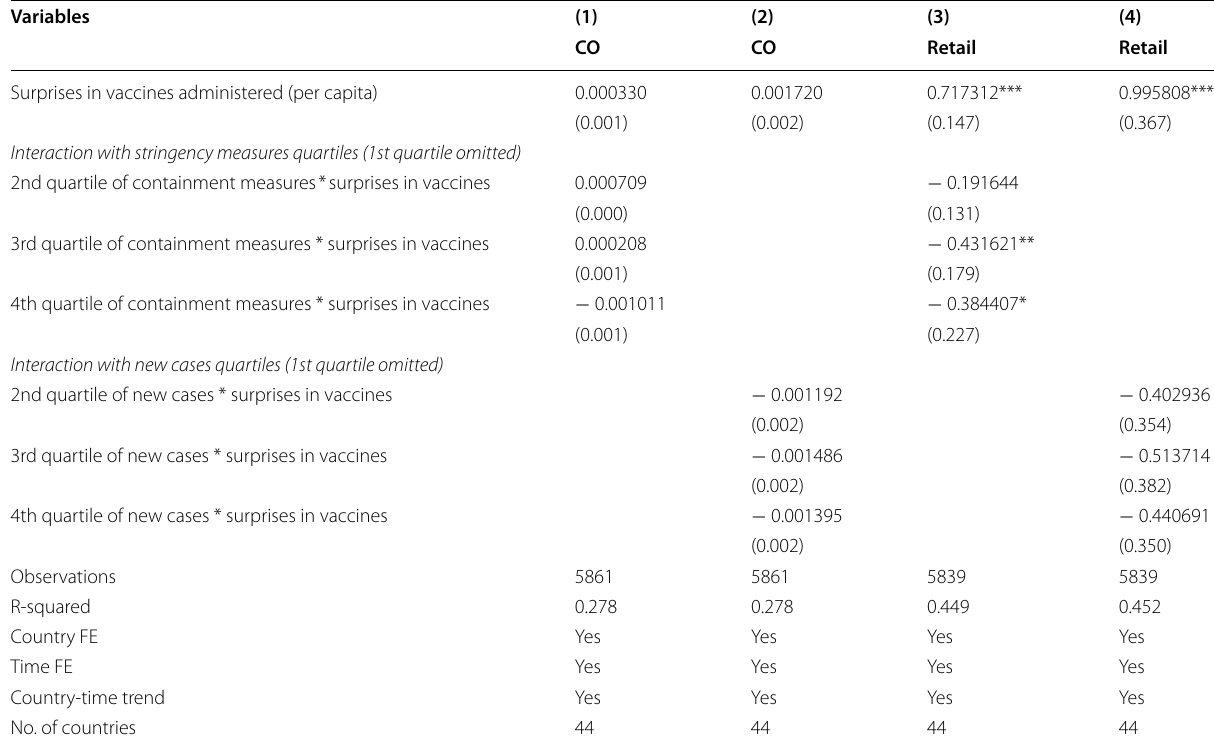
Table 13 Effect of vaccines—role of containment and new cases using CO and Mobility